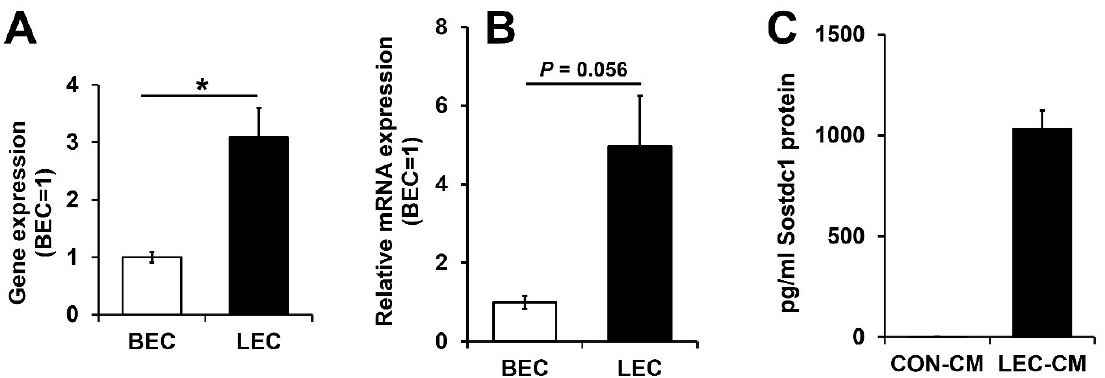
Figure 1. Sostdc1 is highly expressed in lymphatic endothelial cells compared with blood vascular endothelial cells. ( A , B ) The expression of Sostdc1 in matched pairs of human LECs and BECs was determined by microarray ( A ) and by qRT-PCR ( B ). ( C ) Sostdc1 protein levels were measured by ELISA in conditioned media of control (CON-CM) and conditioned media of LECs (LEC-CM). Results are expressed as mean ± standard error of the mean (SEM). Data were analyzed using a two-tailed unpaired t -test. * p < 0.05 compared to the control